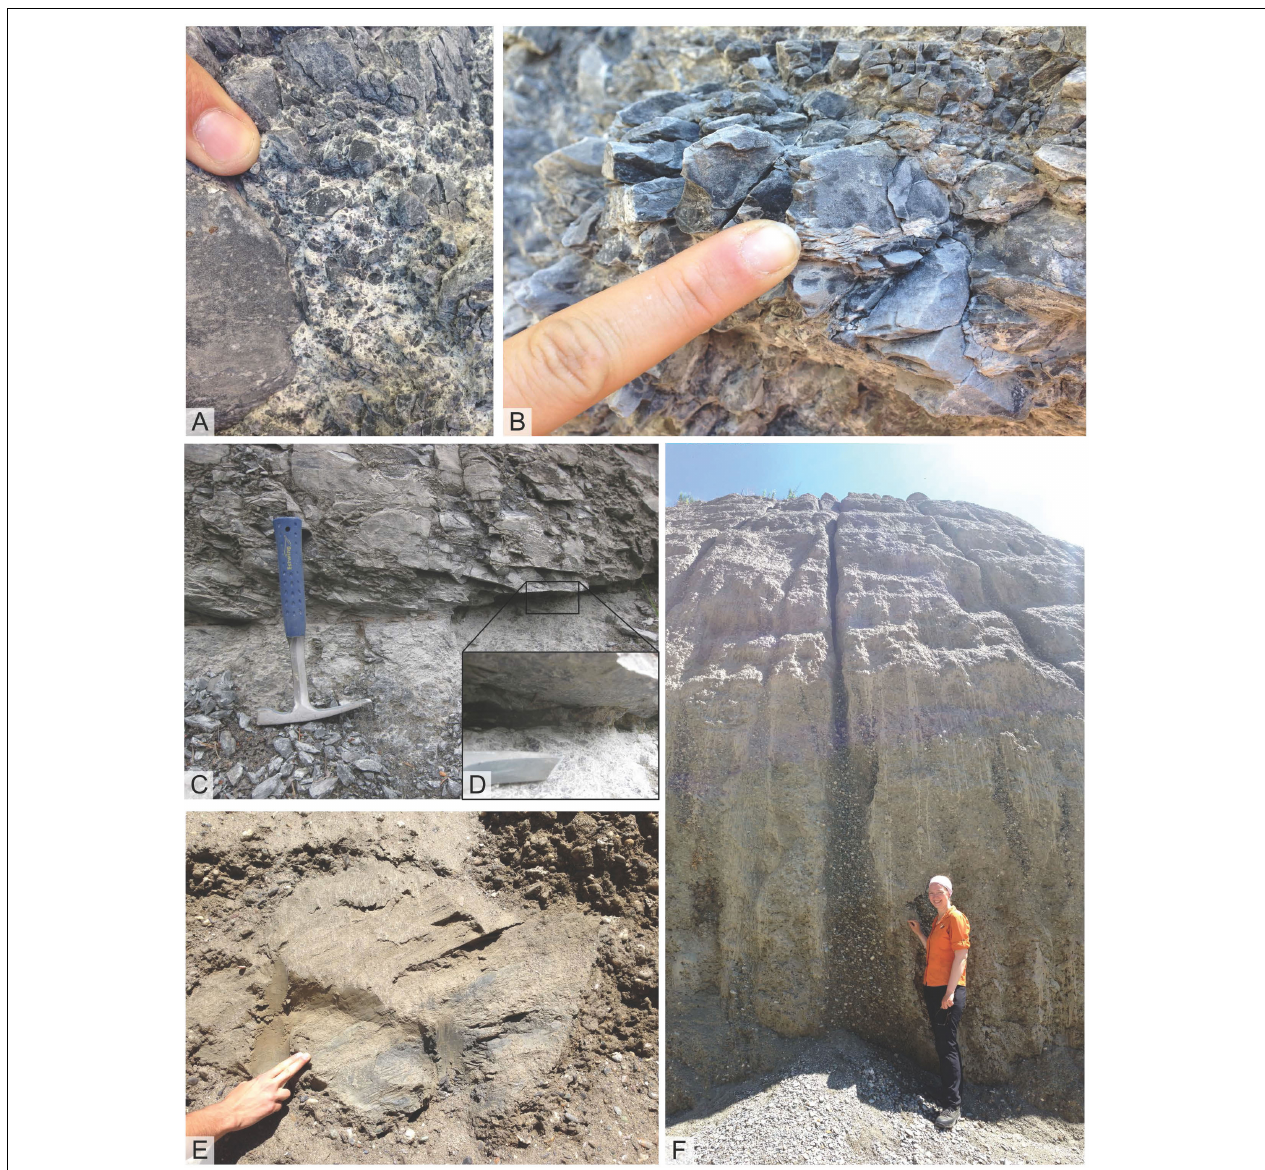
FIGURE 2 | Examples of energy-related features in deposits of the Flims Rock Avalanche (Switzerland): (A) Shattering into cube-like, sharp-angled fragments of different size (cm-dm) in dark gray Helvetic limestone, secondarily cemented with white matrix of rock powder. (B) “Snapshot” of pulverization with multiple grain-internal layers of micro-shearing . (C,D) Grinding within a shear zone. (E) Entrained lump of lake sediment in the Bonaduz gravel deposits. (F) Vertical Pavoni pipes indicate rapid water discharge after deposition (person for